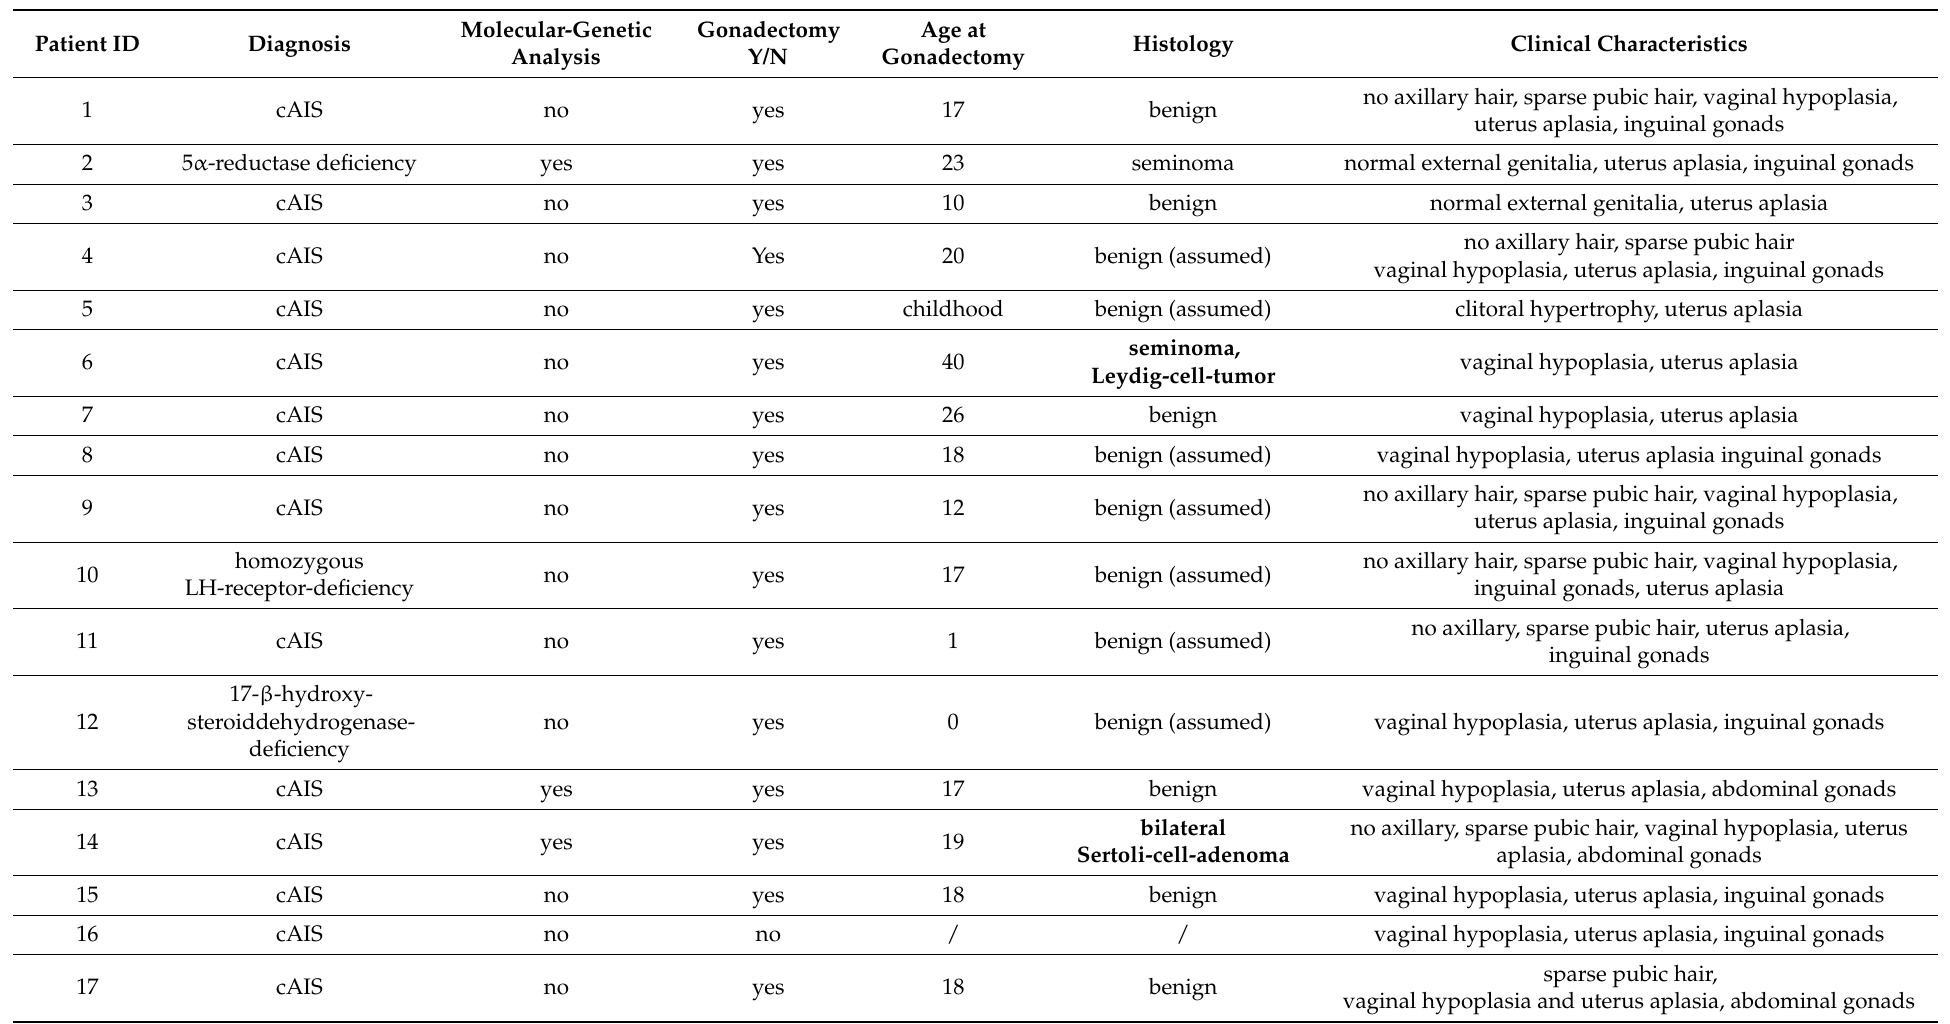
Table 1. Patient